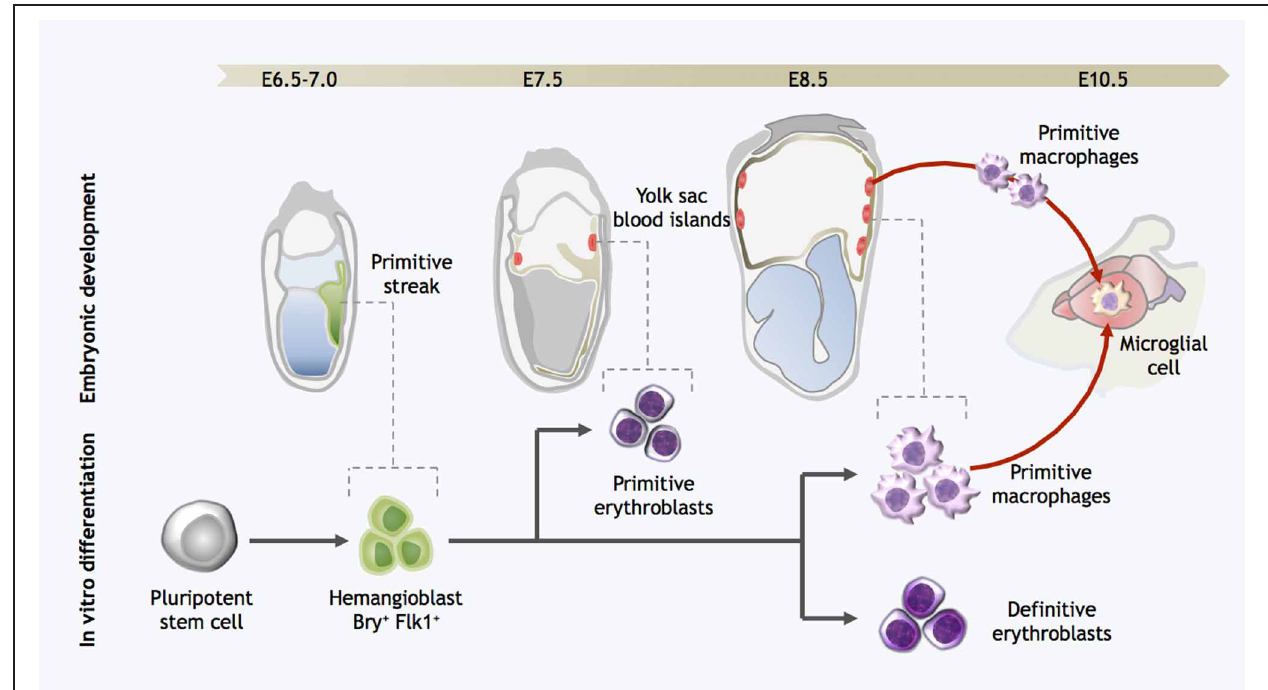
FIGURE 2 | Strategy for directed differentiation of microglial precursors from pluripotent stem cells. Microglial differentiation in vitro can be achieved by recapitulating the steps of yolk sac hematopoiesis. Hemangioblast cells arise in the posterior primitive streak and migrate into the yolk sac, giving rise to the blood islands. Primitive erythroblasts are observed from E7.0–7.5, followed by definitive erythroblasts and primitive macrophages at E8.5. At the